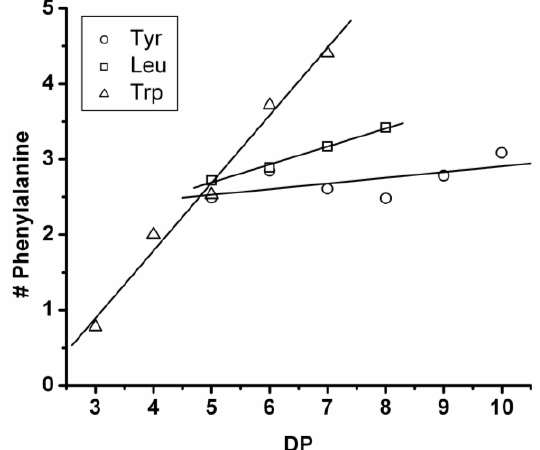
Figure 18. Average number of phenylalanine residues in co-oligomers with Tyr, Leu or